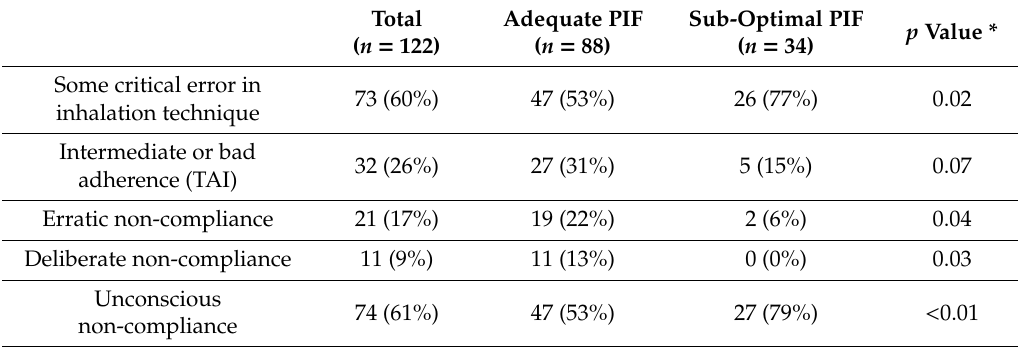
Table 3. Comparative analysis of the inhaled therapy variables, exacerbations and clinical impact in the groups with adequate or suboptimal